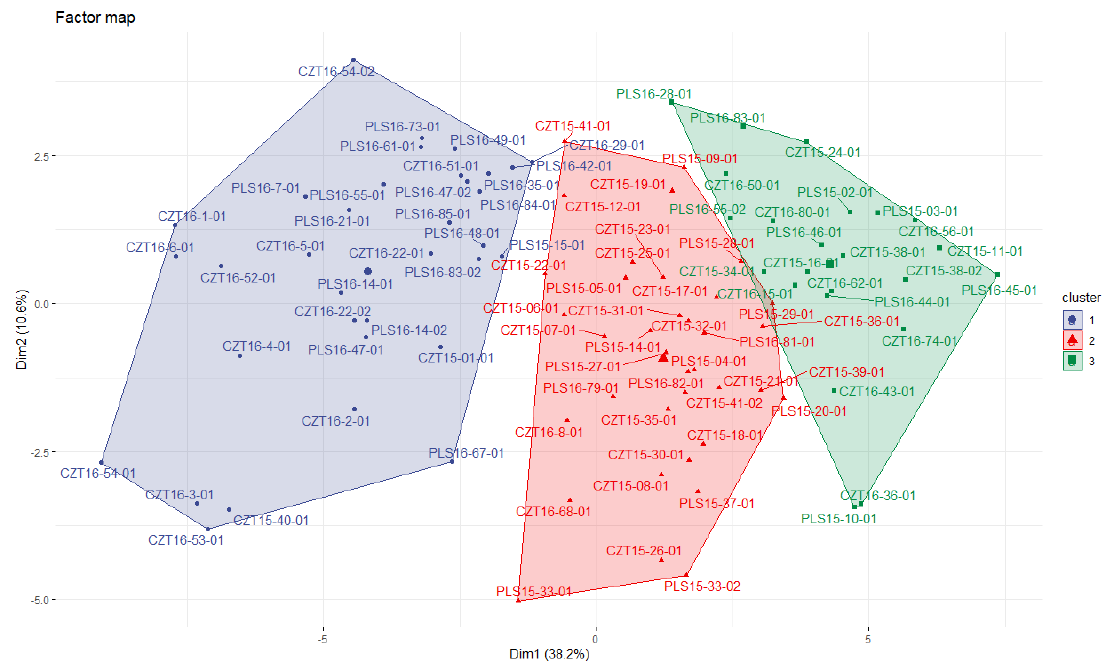
Figure 7. Graph of main components with